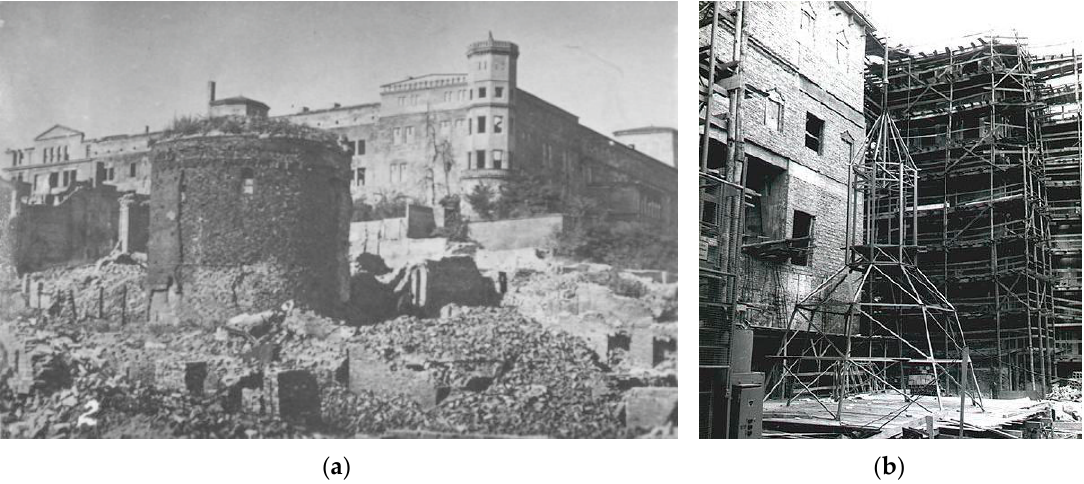
Figure 6. ( a ) The castle after the war damage, source: sedina.pl; ( b ) reconstruction of the south wing, source: sedina.pl.